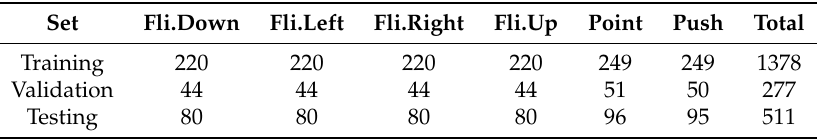
Table 2. The split of the dataset used in this paper.